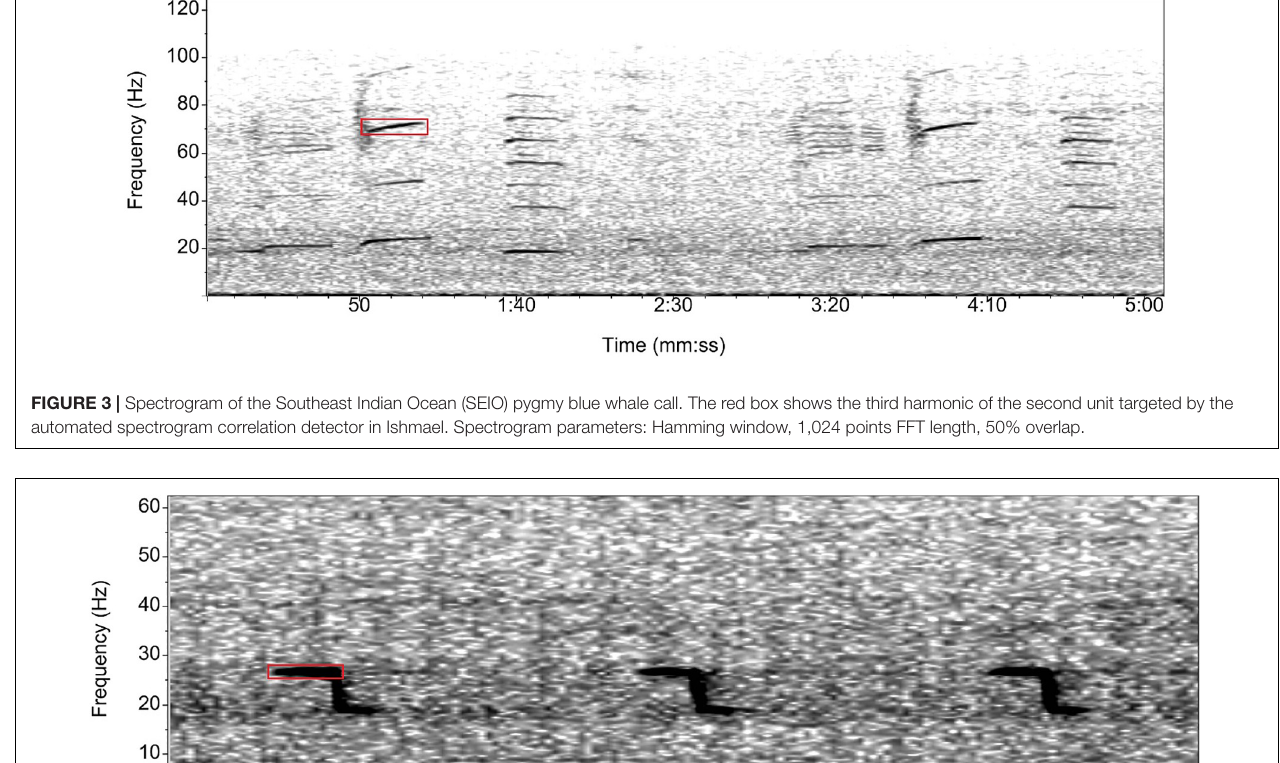
Ishmael v3.0 (Mellinger et al., 2018), based on the third harmonic of the second unit as this component has a high signal-to-noise ratio as described in Balcazar et al. (2015). We used a broad- range detector that sampled over 66–71 Hz to account for the